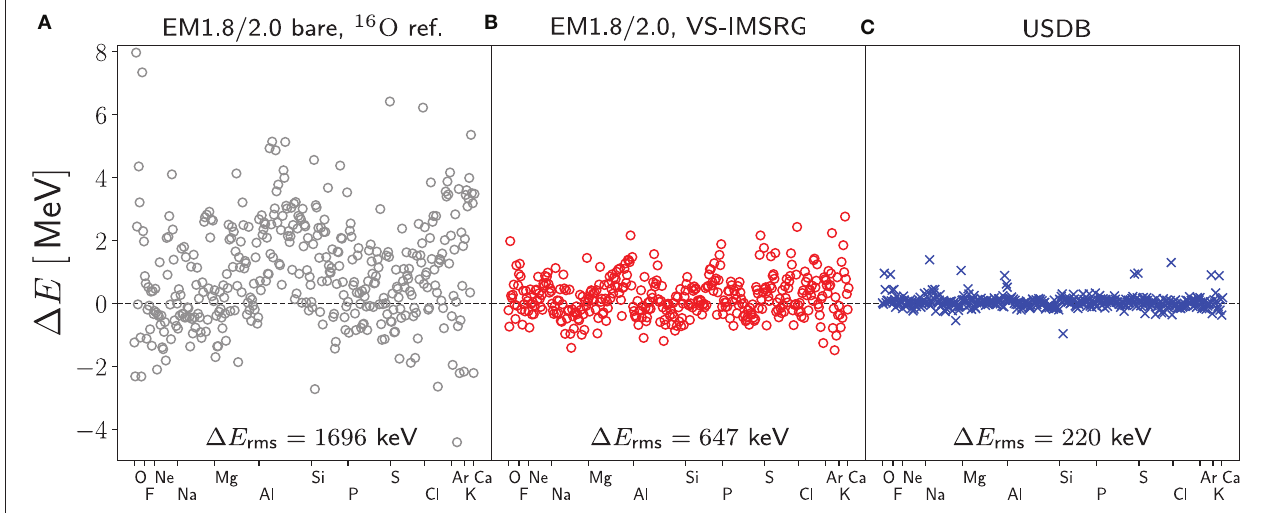
FIGURE 13 | Deviations between theoretical and experimental excitation energies of 391 sd -shell states, for (A) the EM1.8/2.0 interaction without valence decoupling, (B) the same interaction transformed with VS-IMSRG, and (C) the USDB interaction [ 258]. The points correspond to the respective root-mean-square deviations for each interaction. Figure courtesy of R. Stroberg.